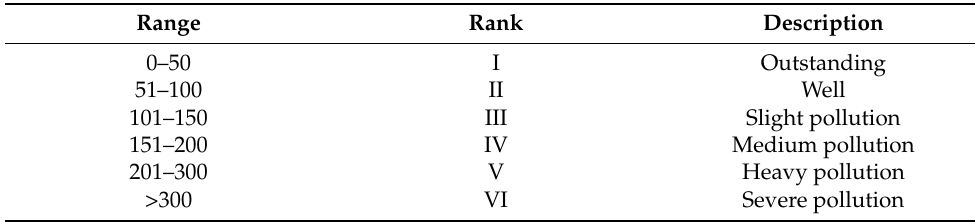
Table 1. AQI range and its